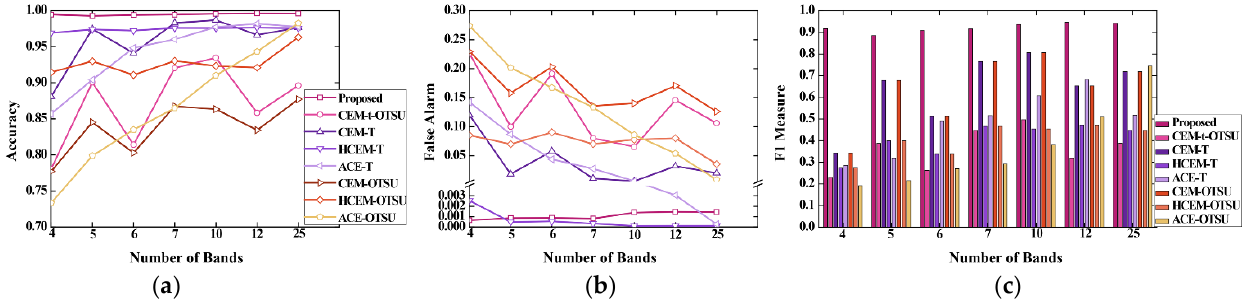
A obtained C F obtained using 1